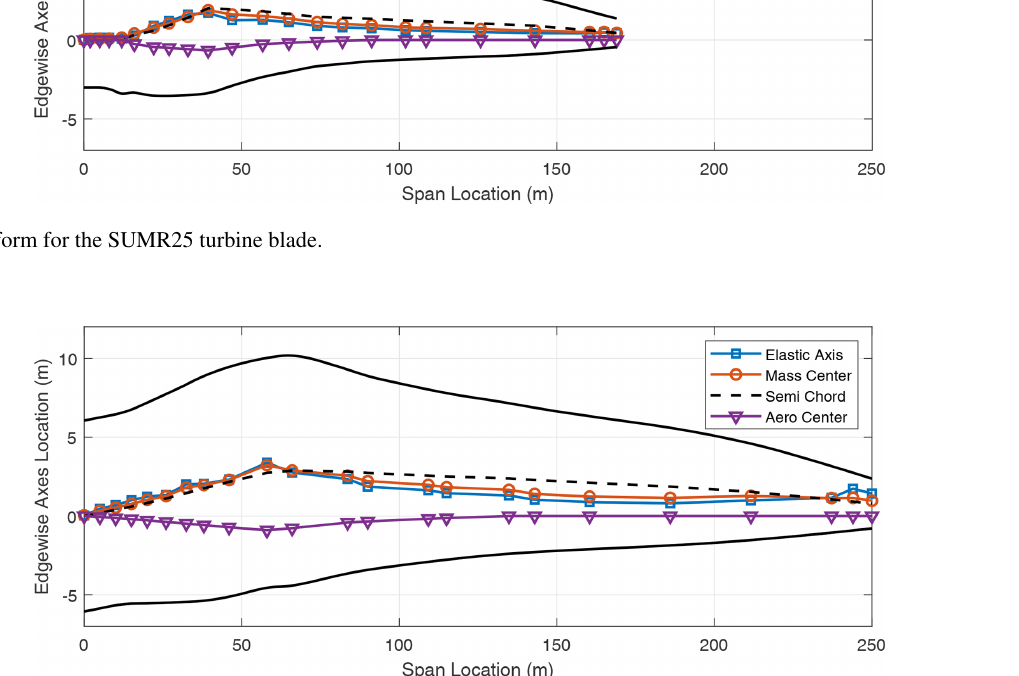
Figure A14. Planform for the SUMR50 turbine